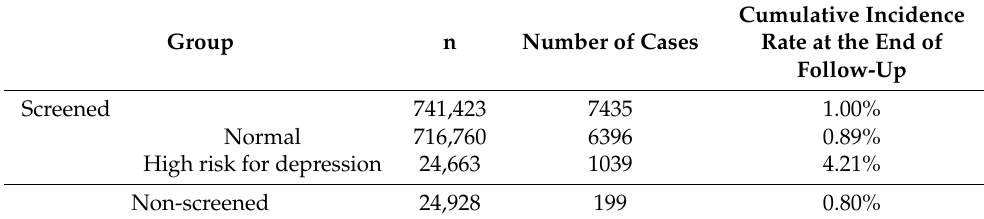
Table 5. Cases of hospitalizations for depression, self-harm, or suicide